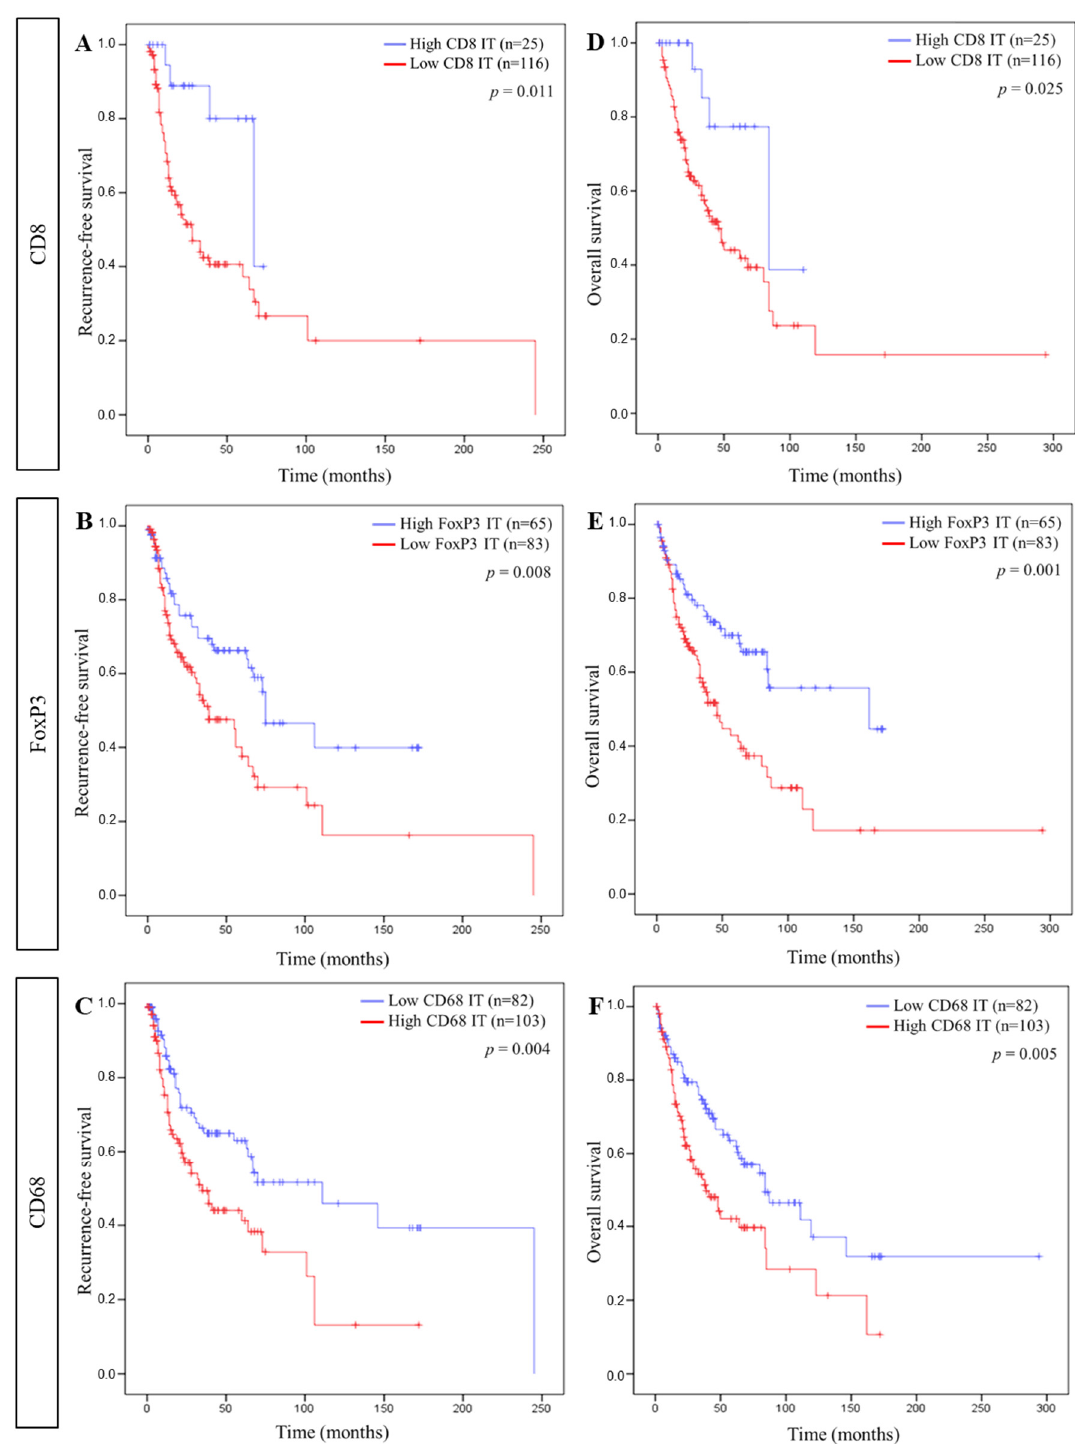
Figure 4. Association between intra-tumoral immune cells and patient survival. Kaplan–Meier curves comparing (( A ), ( B ), and ( C ), respectively) recurrence-free survival (RFS) and CD8, FoxP3, and CD68 and (( D ), ( E ), and ( F ), respectively) overall survival (OS) and CD8, FoxP3, and CD68 in the intra-tumoral compartment (IT).